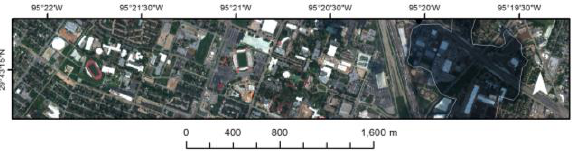
Figure 1. The area of interests. A cloud shadow is visible in the eastern part of the scene The ground truth data contained 15 classes of LC/LU. In each